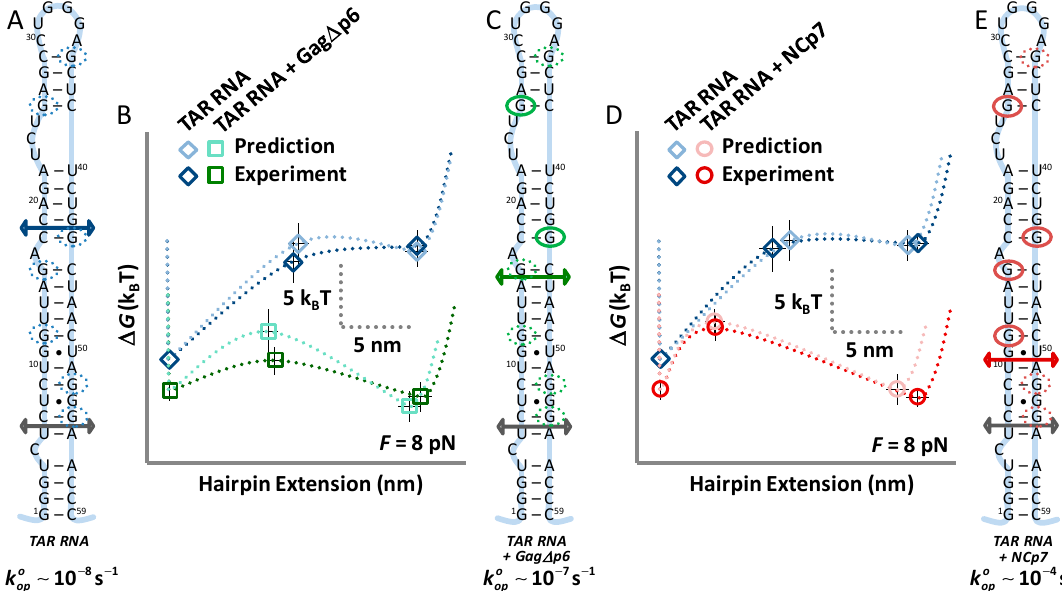
Figure 5. Unlike Gag ∆ p6, NCp7 dramatically shifts the location of the transition barrier of the TAR hairpin. ( A ) The transition state of this irregular hairpin is marked by an arrow (blue), while exposed G bases are highlighted (blue dotted circles), and the natural rate of hairpin opening is low (10 − 8 · s − 1 ). ( B ) The measured hairpin landscape (blue) matches values predicted from mfold (cyan), including the e ff ects of hairpin fraying, which unfold the lowest stem (grey arrow). ( C ) Modeled destabilization by Gag ∆ p6 binding is highlighted (solid green ovals show the sites destabilized by protein binding) and the resulting best match for the unfolding data is compared to TAR in ( B ) (data—green, model—teal). While both the energy of unfolding and the barrier decrease, the transition state is not significantly shifted (green arrow), and the opening rate is only slightly a ff ected (10 − 7 · s − 1 ). ( D , E ) NCp7 destabilizes the entire upper loop (solid red ovals are sites contributing to destabilization), leading to a marked shift in the transition state location (red arrow) toward the folded state (grey arrow) with a corresponding increase in the unfolding rate (10 − 4 · s − 1 , data—red, model—pink). Landscapes are shown under the e ff ect of an 8 pN external force. TAR RNA hairpin controls measured in this work and previously are both shown to match mfold predictions.